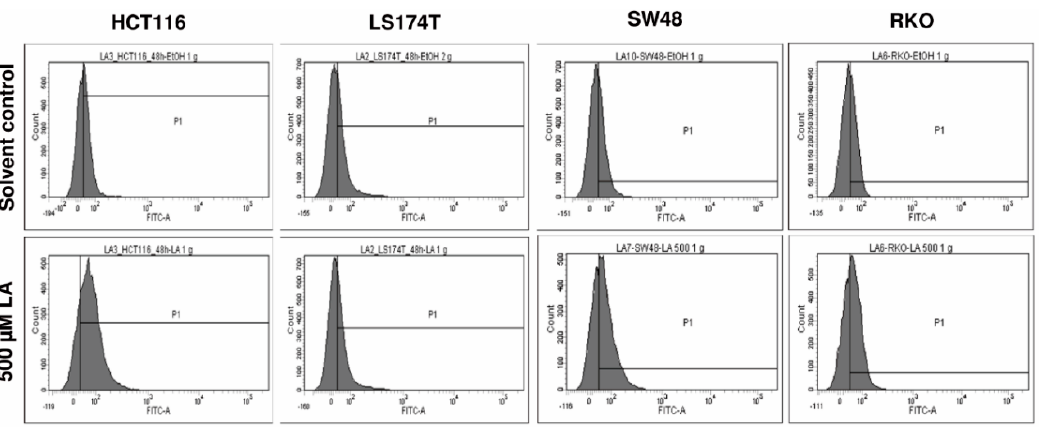
Figure A2. Effect of LA on autophagosome formation in different CRC cells. Cells were treated with LA or EtOH as solvent control for 48 h, harvested and stained using the CytoID® Green Detection kit. Cells were then analyzed by flow cytometry. Representative histograms are shown.